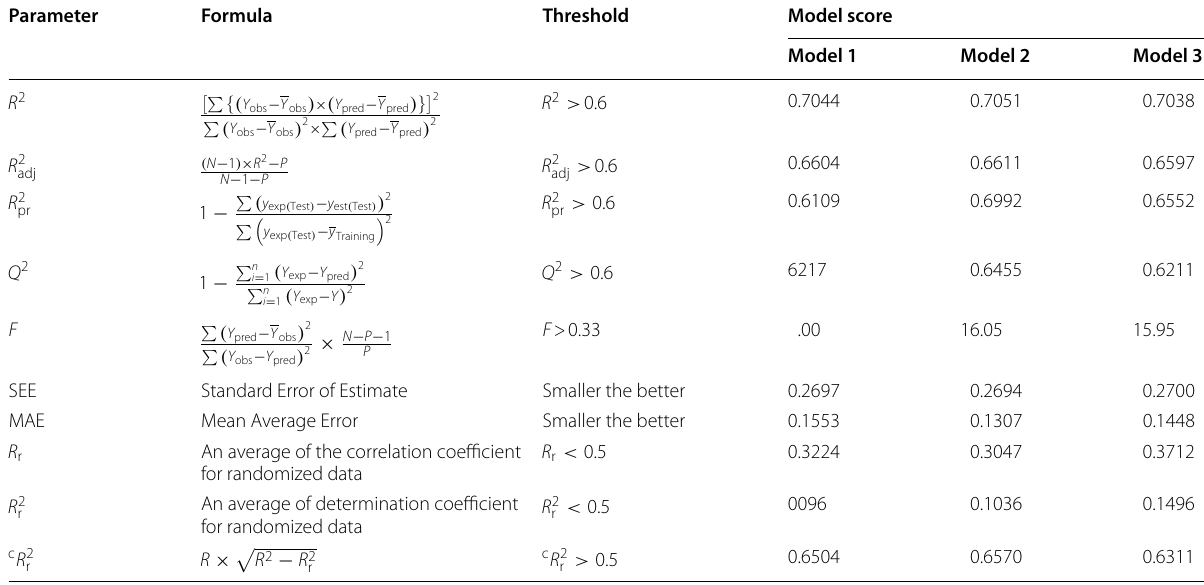
Table 2 Model parameters, formula, threshold values, and models scores Parameter